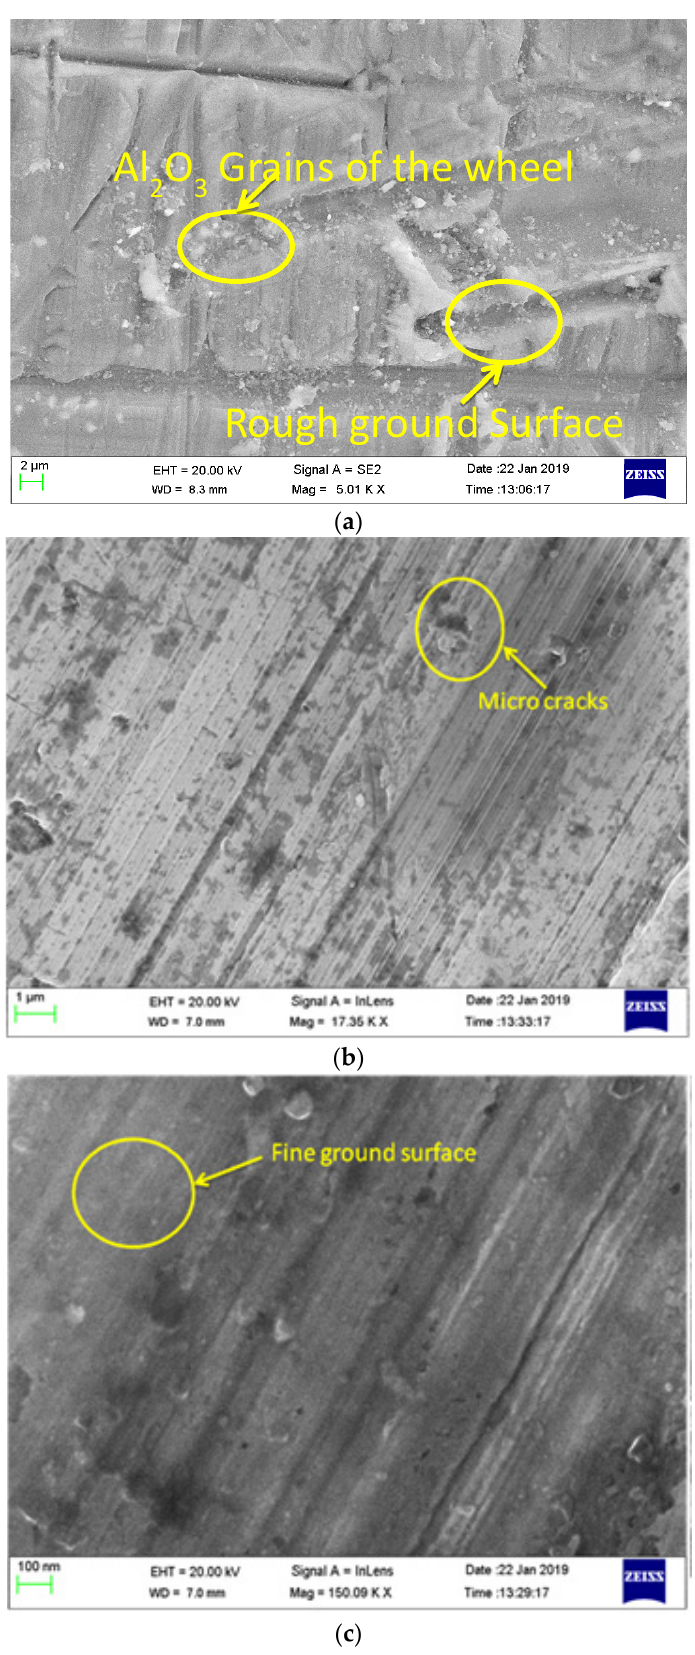
Figure 10. ( a ) Micro-structure of machined surface under SAE20W40. ( b ) Micro-structure of machined surface under veg oil. ( c ) Micro-structure of machined surface under veg oil + TiO 2 .